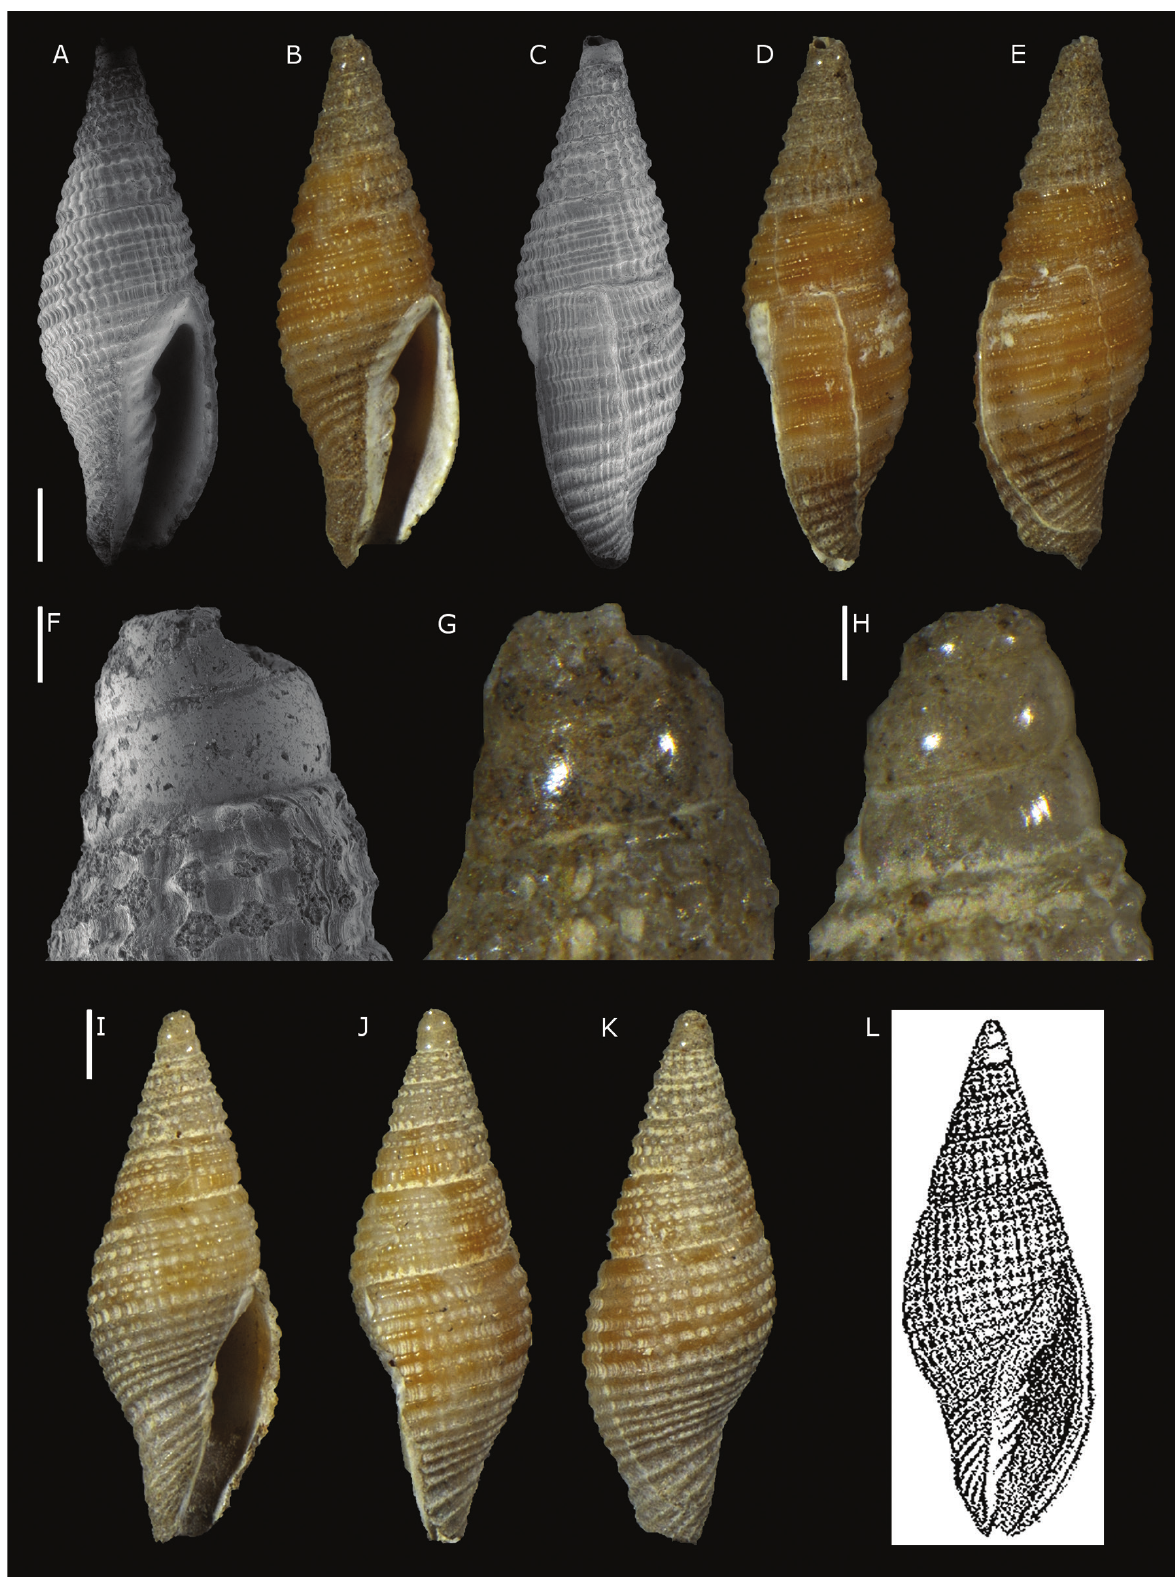
Figure 19. Mitra gonatophora Sturany, 1903, Station 48 (Yanbu’ al Bahr, Saudi Arabia, Red Sea). A–G . Figured syntype, NHMW 84210: front ( A–B ), right side ( C–D ), back ( E ), protoconch ( F–G ). H–K . Syntype, NHMW 84211: protoconch ( H ), front ( I ), right side ( J ), back ( K ). L . Original figure by Sturany (1903). Scale bars: A–E , I–K : 1 mm, F–H : 0.2